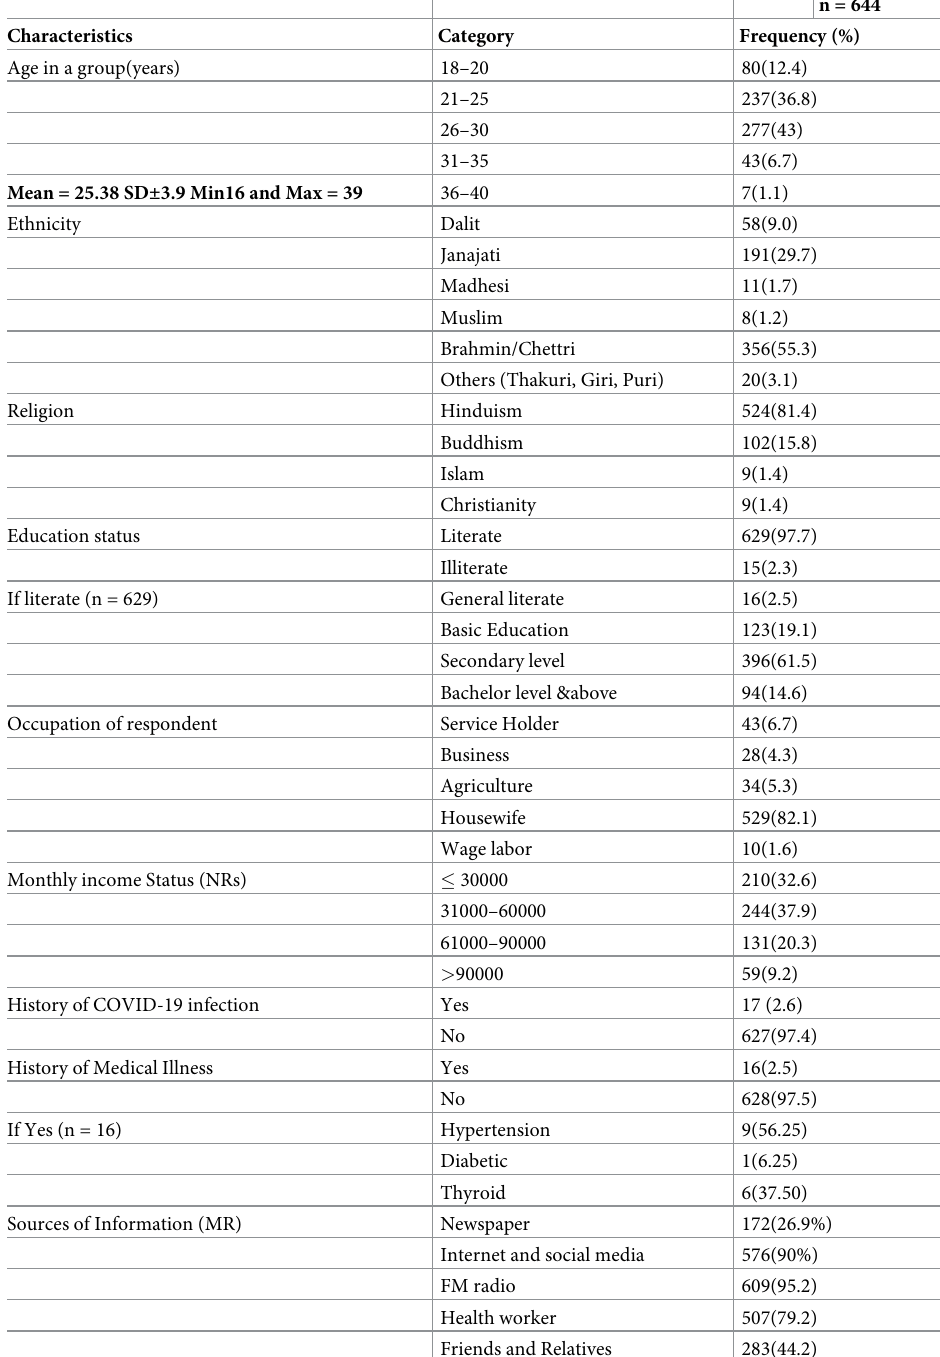
Table 1. Sociodemographic characteristics of the